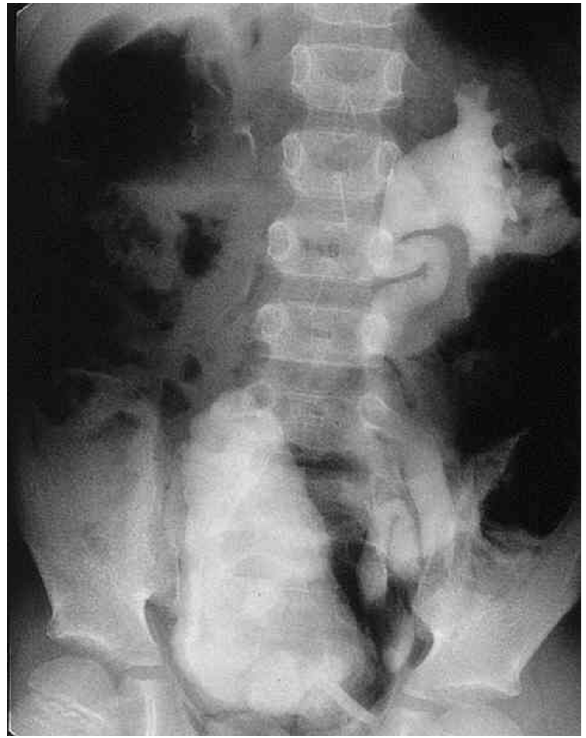
Figure 1 – Picture of the dilated left ureter and the thick-walled bladder and the Christmas-tree shaped bladder of the 7 years- old